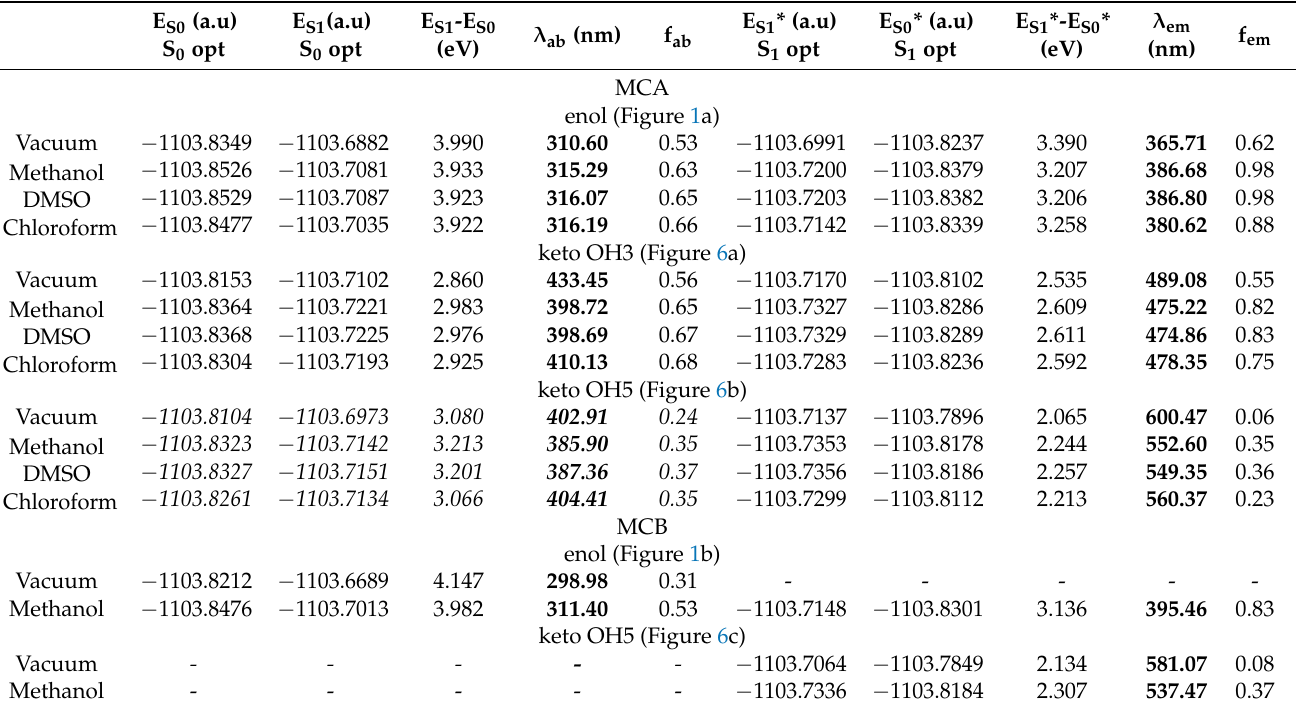
Table 1. Absorption and emission of MCA and MCB obtained at TDDFT-M06-2X/6-31++G(d,p) level of